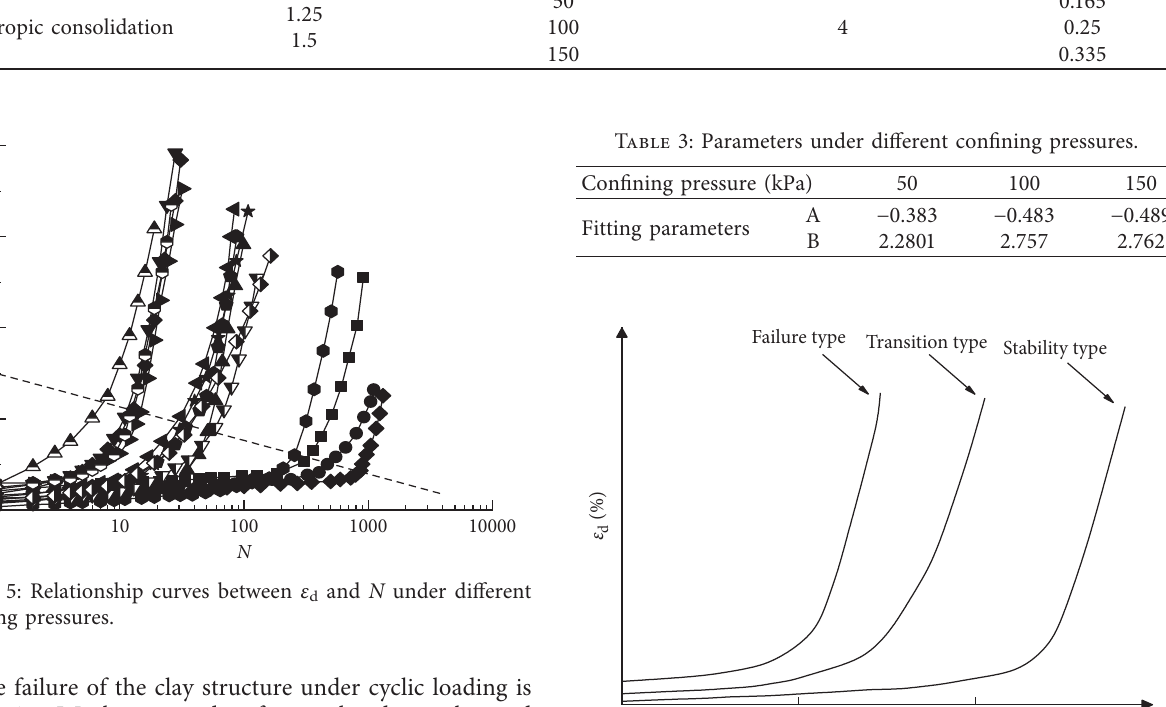
Figure 6: Three types of simplified curves between ε